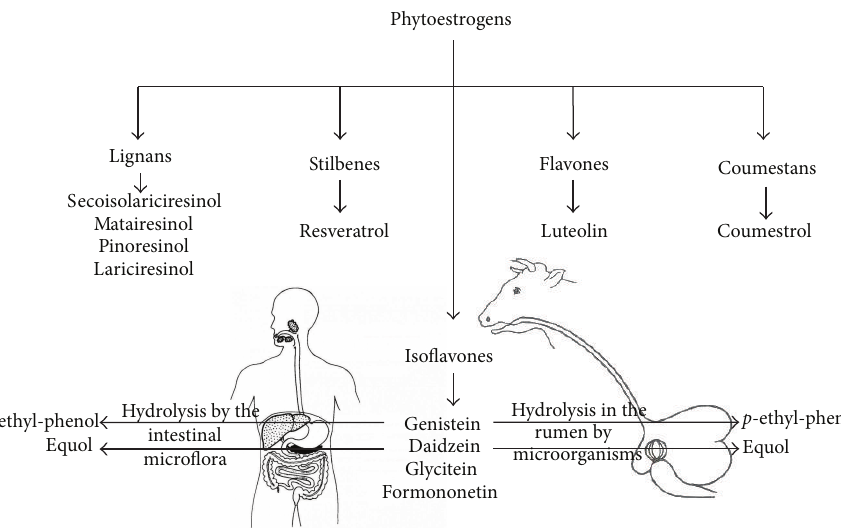
Figure 1: Classification and metabolism of